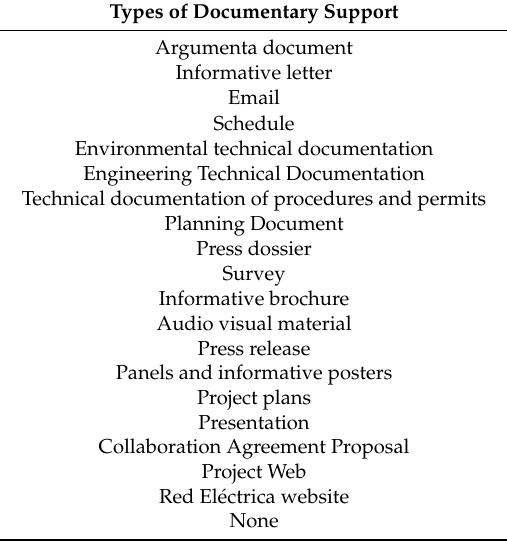
Table A3. Types of documentary support to execute the